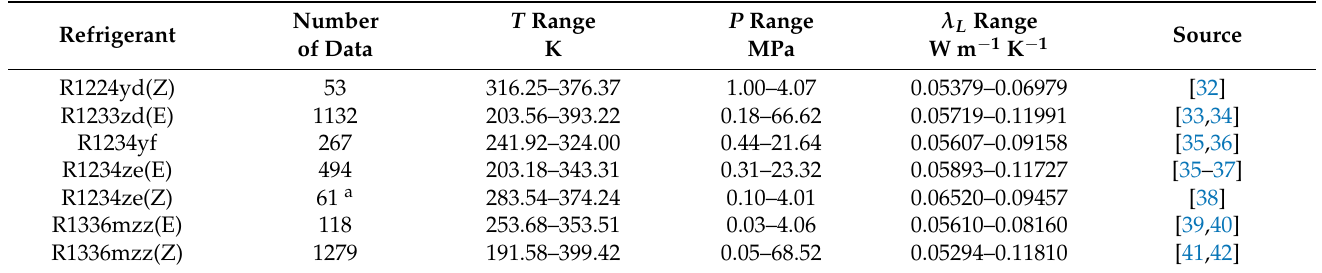
Table 1. Summary of the experimental liquid thermal conductivity data for low-GWP refrigerants studied in this work.